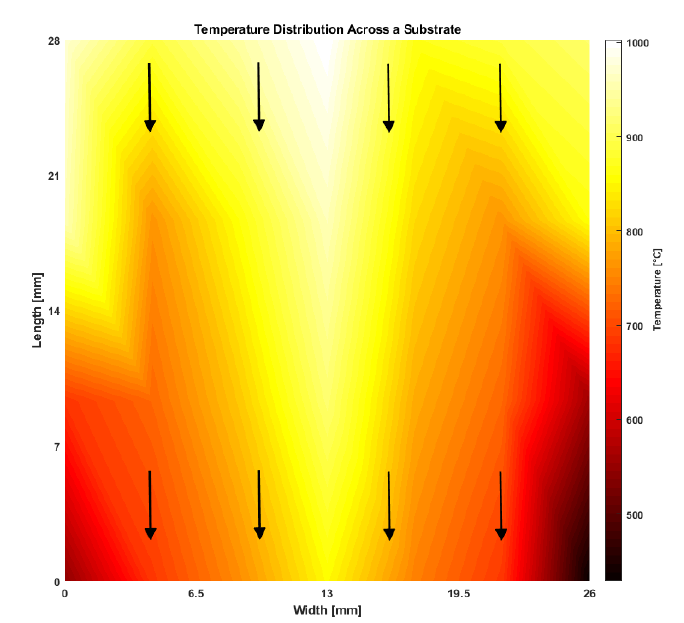
Figure 6. Thermal map of the substrate temperatures, T substrate , across the middle of the catalytic sub- strate. Black arrows indicate the direction of flow. The experiment was conducted with 6000 mL/min air flow through a 2SSC